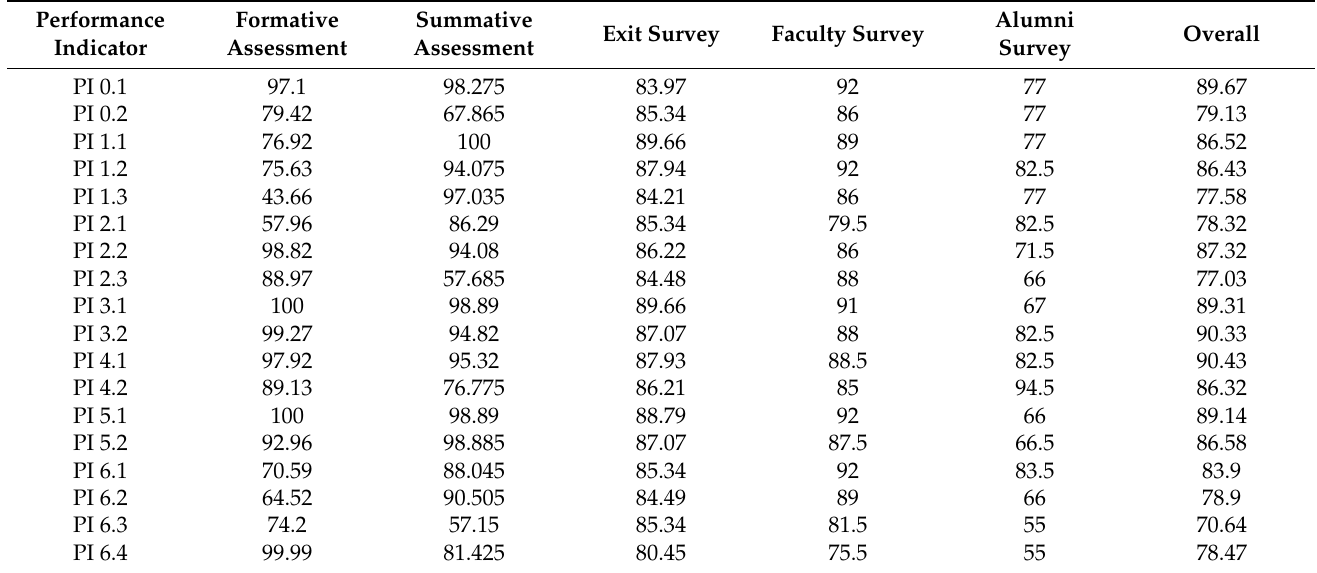
Table 1. Attainment data of Performance